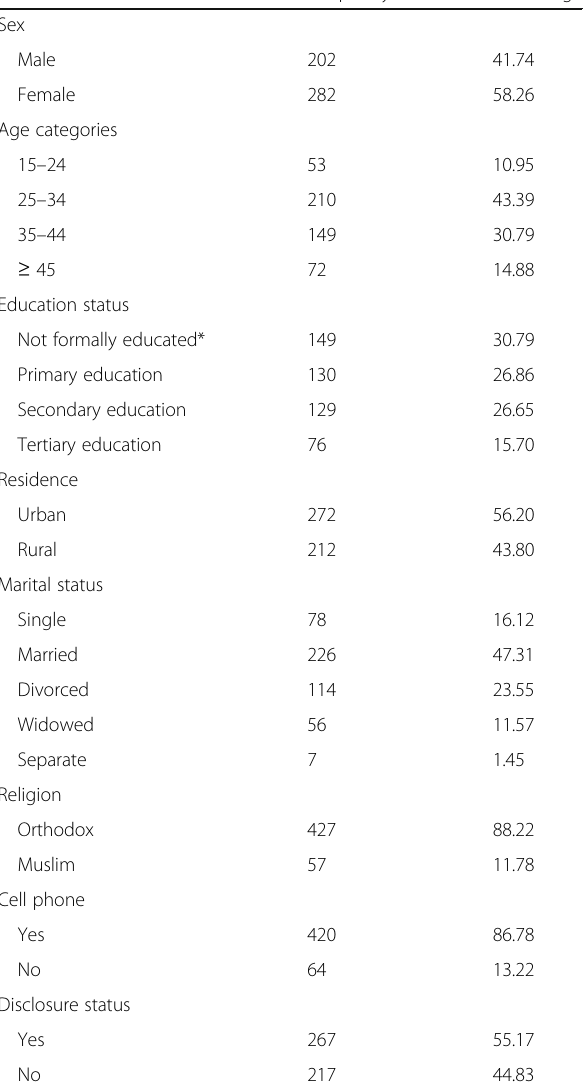
Table 1 Socio-demographic characteristics of HIV-positive adult individuals on ART at Debre Markos Referral Hospital who were